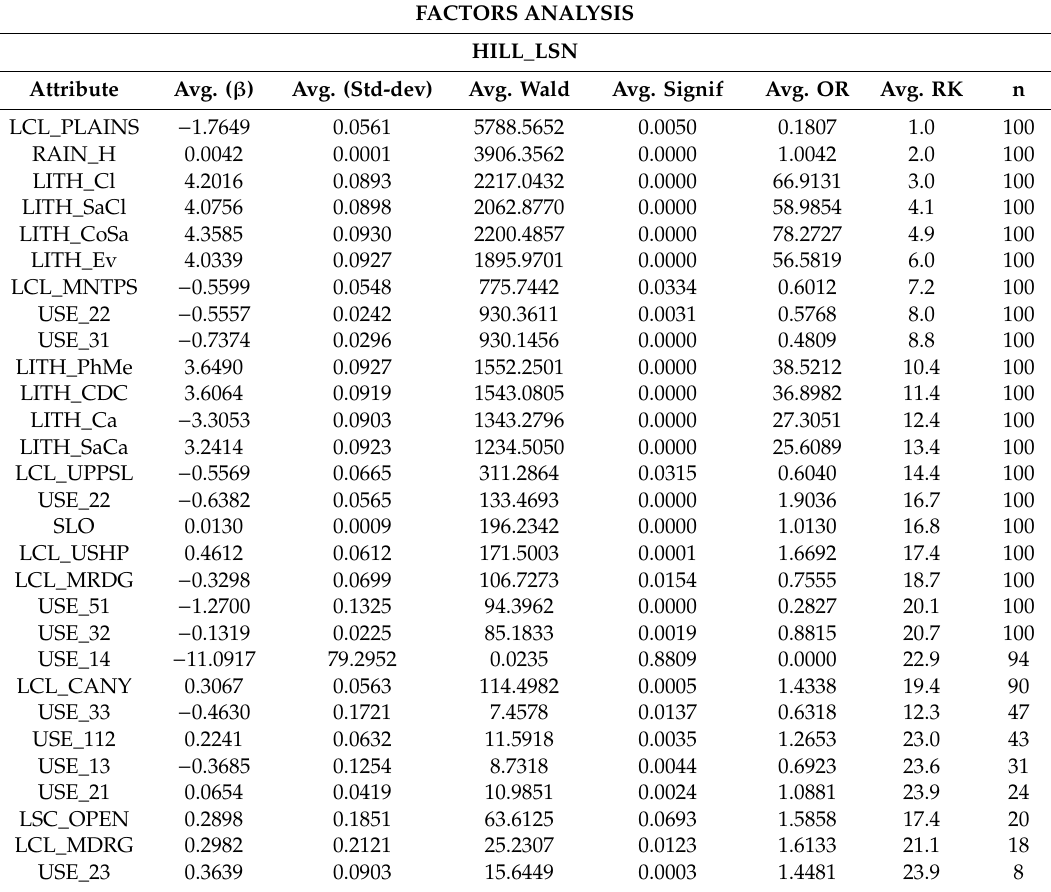
Table 6. Factors analysis for